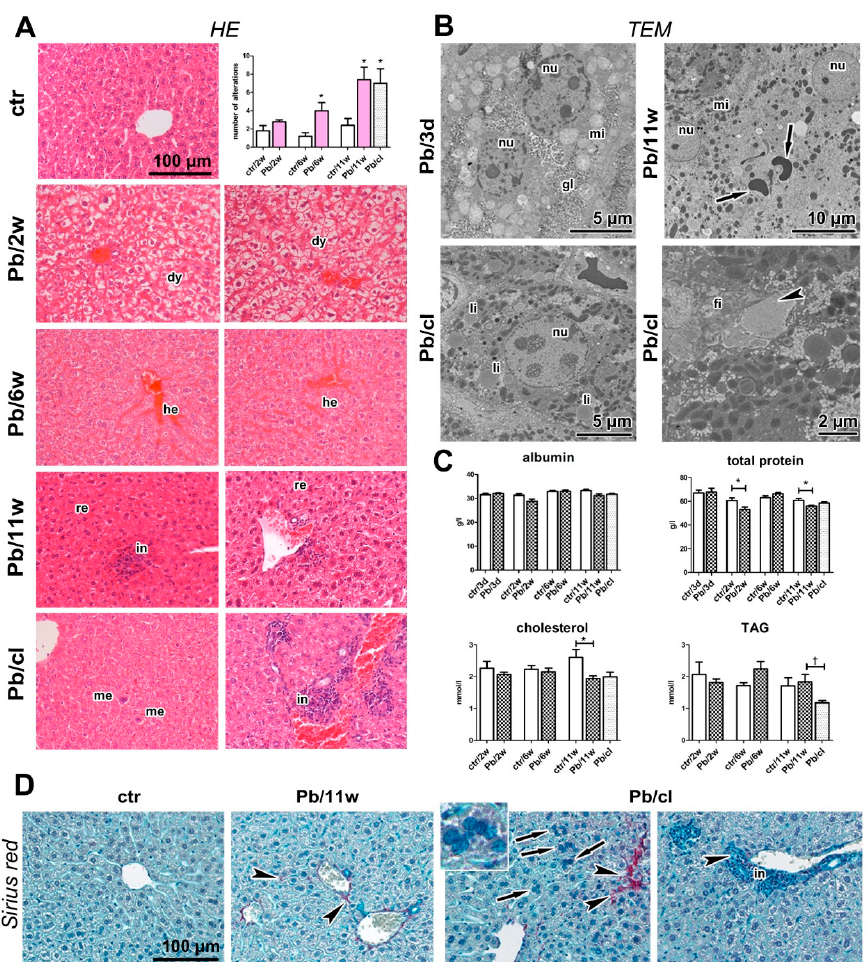
Figure 6. The effect of Pb(NO 3 ) 2 NP inhalation and its clearance on the liver. ( A ) The liver in control animals was without serious pathological changes (HE staining). The liver after 2, 6, and 11-weeks of Pb(NO 3 ) 2 NP inhalation exhibited hepatocyte dystrophy (dy), remodeling in liver parenchyma (re) and expressive hemostasis (he). We observed infiltrates (in) and megakaryocytes (me) in liver. Statistical evaluation of the histopathological changes in both control and Pb(NO 3 ) 2 NP-exposed groups in the experiments delineated according to Table S4. The graphs values denote average ± SD; * p < 0.05 compared with the corresponding control group (ctr) by unpaired t -test. ( B ) Ultrastructure of liver in TEM. Binucleated hepatocyte with regularly distributed organelles (mitochondria, mi) and glycogen (gl) in a 3-day Pb(NO 3 ) 2 NP group. Enlarged binucleated hepatocyte with altered nuclei (nu), randomly distributed organelles, and free erythrocytes (arrows) in cytoplasm in an 11-week Pb(NO 3 ) 2 NP group. Hepatocyte with physiological morphology of nucleus and regularly arranged organelles in Pb/cl; however, lipid droplets (li) present in increased number. Perisinusoidal fibroblast (fi) and accumulated collagen fibrils (arrowhead) in space of Disse in a Pb/cl group. Scale bars are displayed individually for each picture. ( C ) The blood levels of albumin, total protein, cholesterol, and triacylglycerols after Pb(NO 3 ) 2 NP inhalation. The graphs values denote average ± SD for 5 mice / group; * p < 0.05 compared with the corresponding control group (ctr), † p < 0.05 compared with the corresponding Pb(NO 3 ) 2 NP group by unpaired t -test. ( D ) Sirius Red staining of liver samples to detect collagen fibrils. After 11-week Pb(NO 3 ) 2 NP inhalation and in Pb / cl group, the collagen fibrils were observed around small blood vessels and inside liver parenchyma (arrowheads). Polynucleated hepatocytes were observed in Pb / cl group (inbox, arrows). Scale bar in panels ( A , D ) = 100 µ